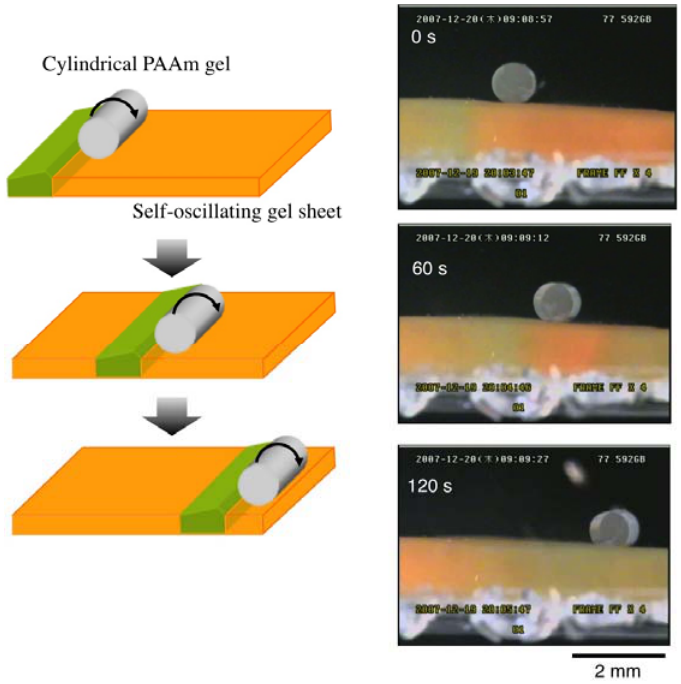
and HNO ) (right) 3 3